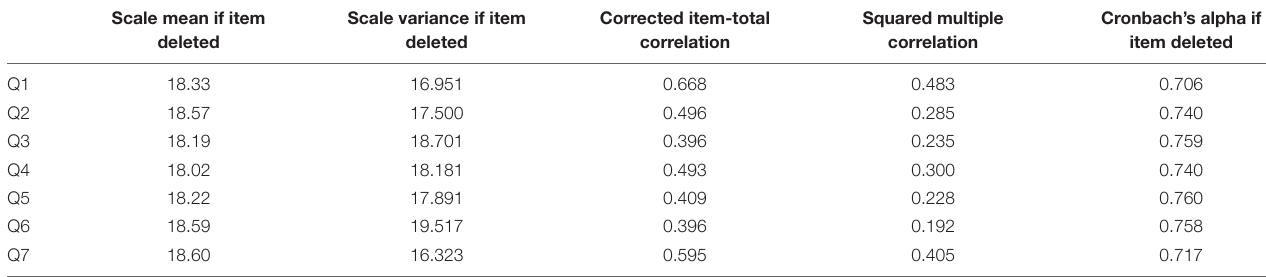
TABLE 1 | Item-total statistics of the NCI.